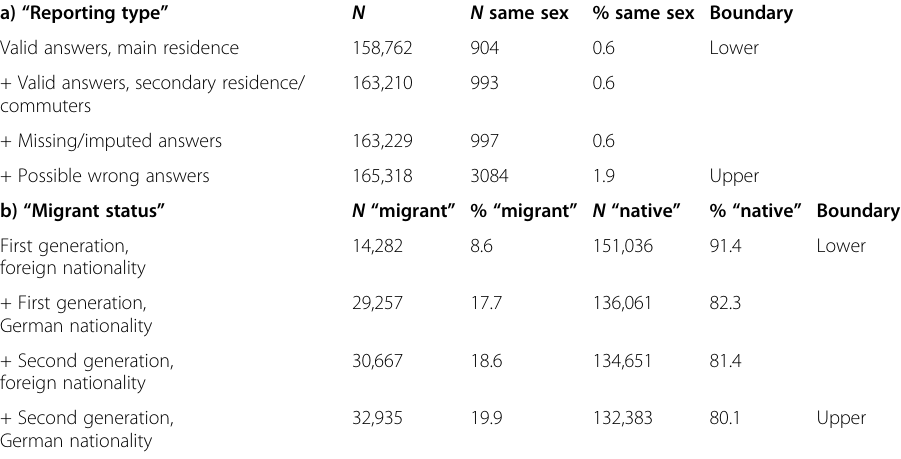
Table 1 Overview about the total sample by using different definitions for “ reporting type ” and “ migrant status ”